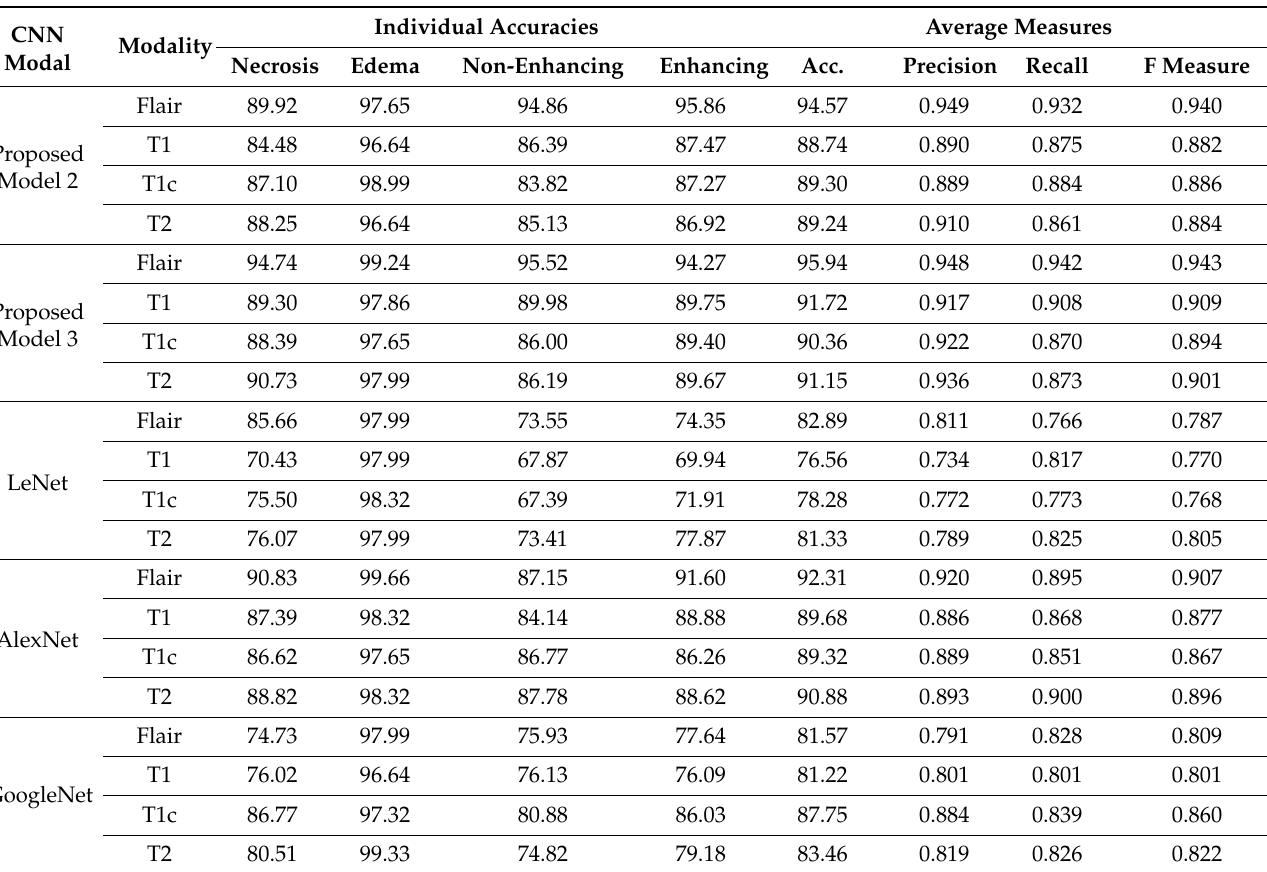
Table 12. Multiclass Glioma Tumor Classification results using proposed CNN models classifiers compared with other well-known CNN models for brain HGG MR